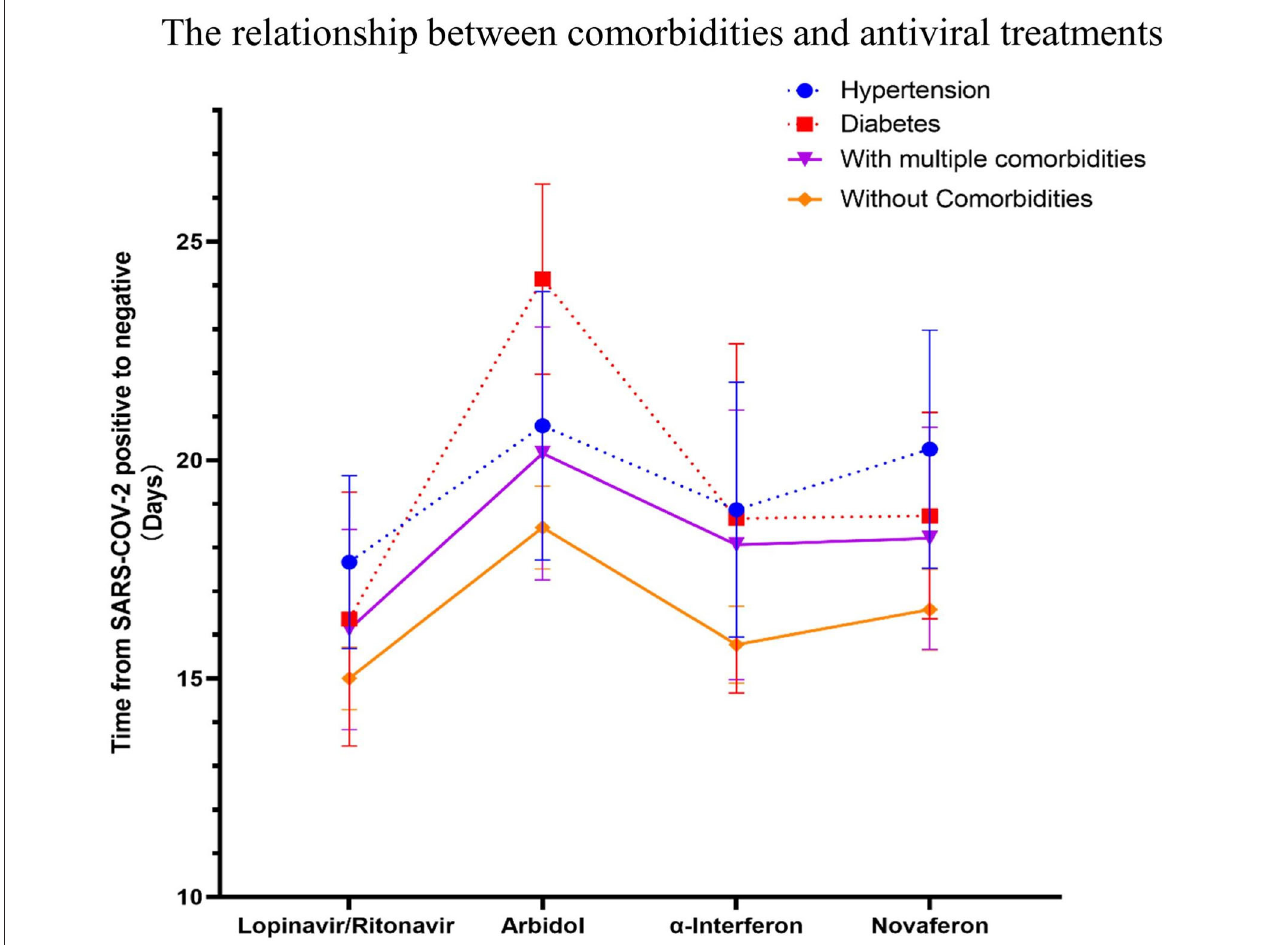
FIGURE 6 | The relationship between specific comorbidities and the conversion time from real-time PRC (rtPCR) positive to negative during antiviral treatment. The time to conversion from rtPCR positive to negative was compared for patients with hypertension, diabetes, multiple comorbidities, and no comorbidities treated with different antiviral drugs. Patients with diabetes had a longer duration of rtPCR conversion than patients without comorbidities in the Arbidol group during antiviral drug treatment ( p = 0.11). Data are represented the mean ±